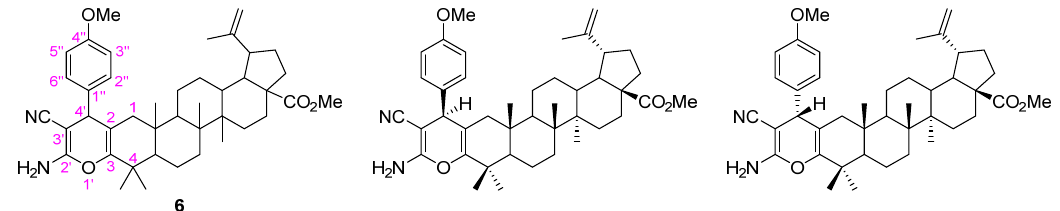
Figure 5. Adopted numbering system and structures of two diastereomers of the pyran-fused BoOMe compound 6 .